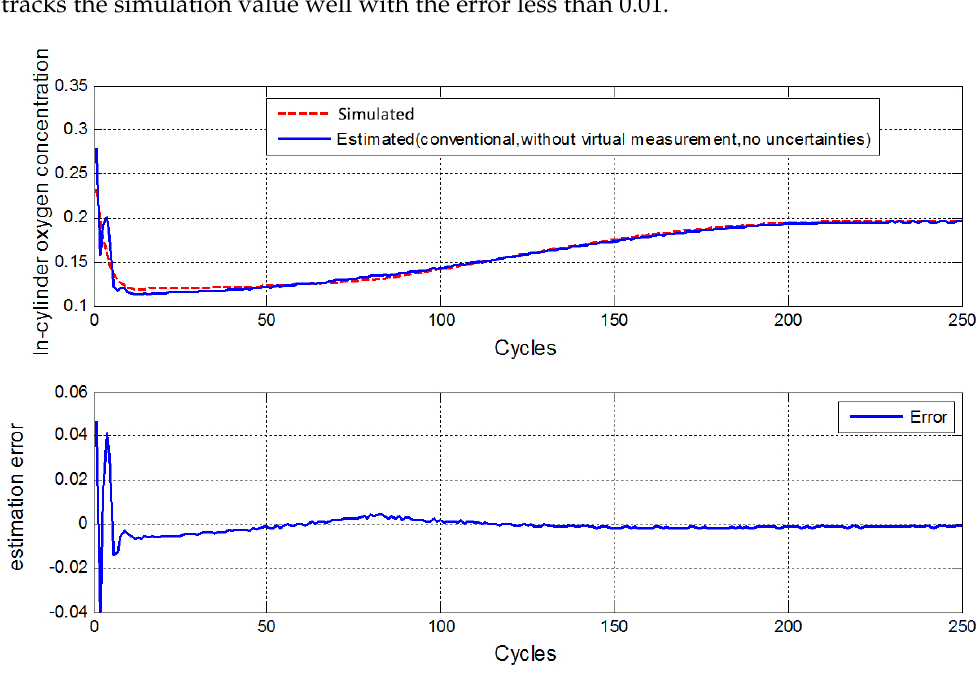
Figure 9. Performance of dynamical model based method (no